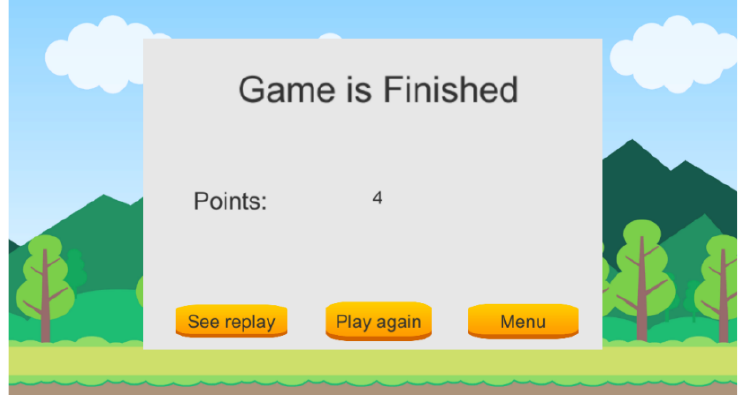
Figure 4. The display showing choices and scores after finishing the game.